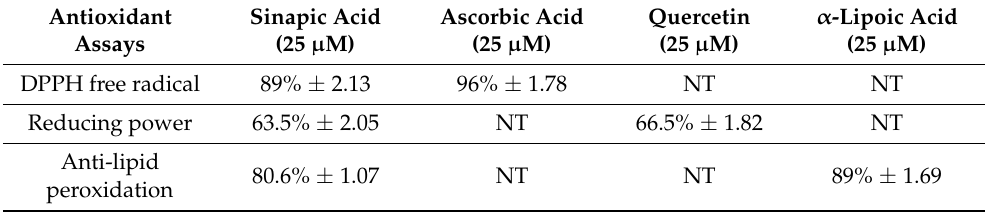
Figure 2. Docked images of sPLA 2 -IIA (1POE) with genistein (standard) and sinapic acid: 2D Ligplot analysis and the crystal structure of sPLA2-IIA (1POE) with standard genistein ( A ) and sinapic acid ( B ). Hydrogen bonds are presented by the green dashed line, and the unit of distance was set as Å. Table 1. The binding energy, H- bonds and hydrophobic interactions of genistein and sinapic acid Table 2. The antioxidant activity of sinapic with human sPLA 2 -IIA (PDB ID: 1POE).